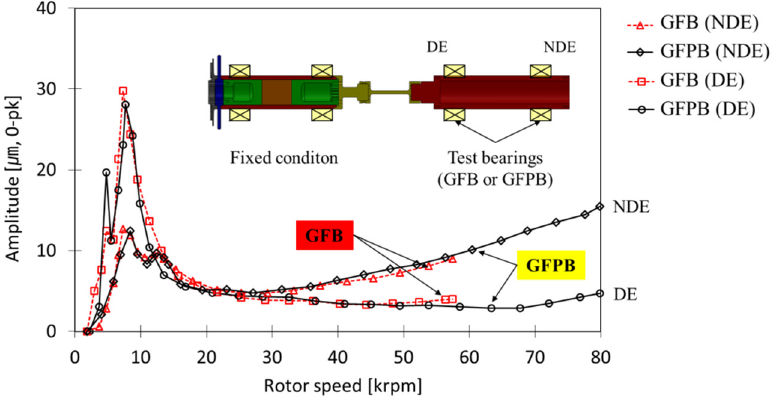
Figure 10. Filtered synchronous vertical motions measured at DE and NDE sides for GFB and GFPB.